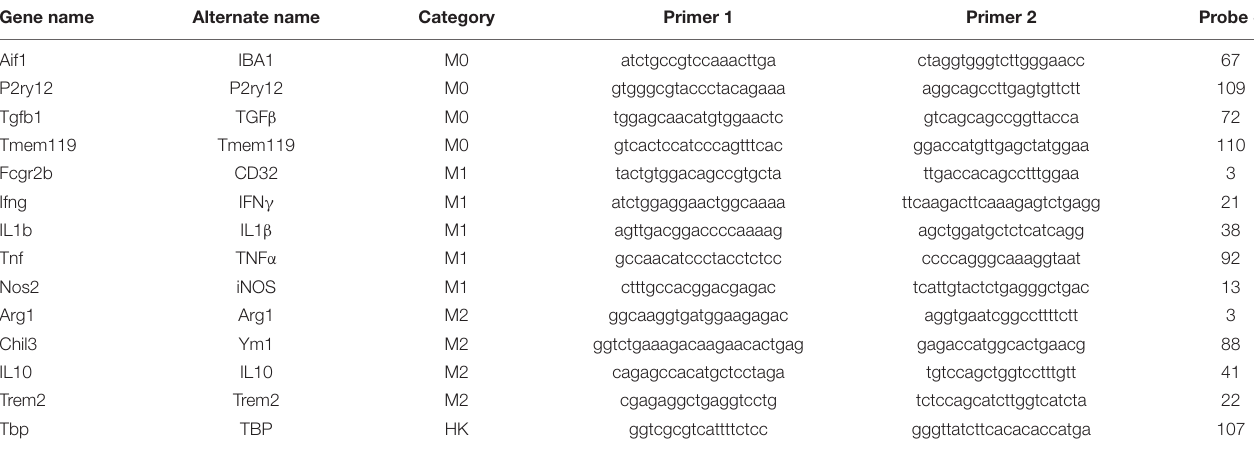
TABLE 1 | Primers and probes for TaqMan